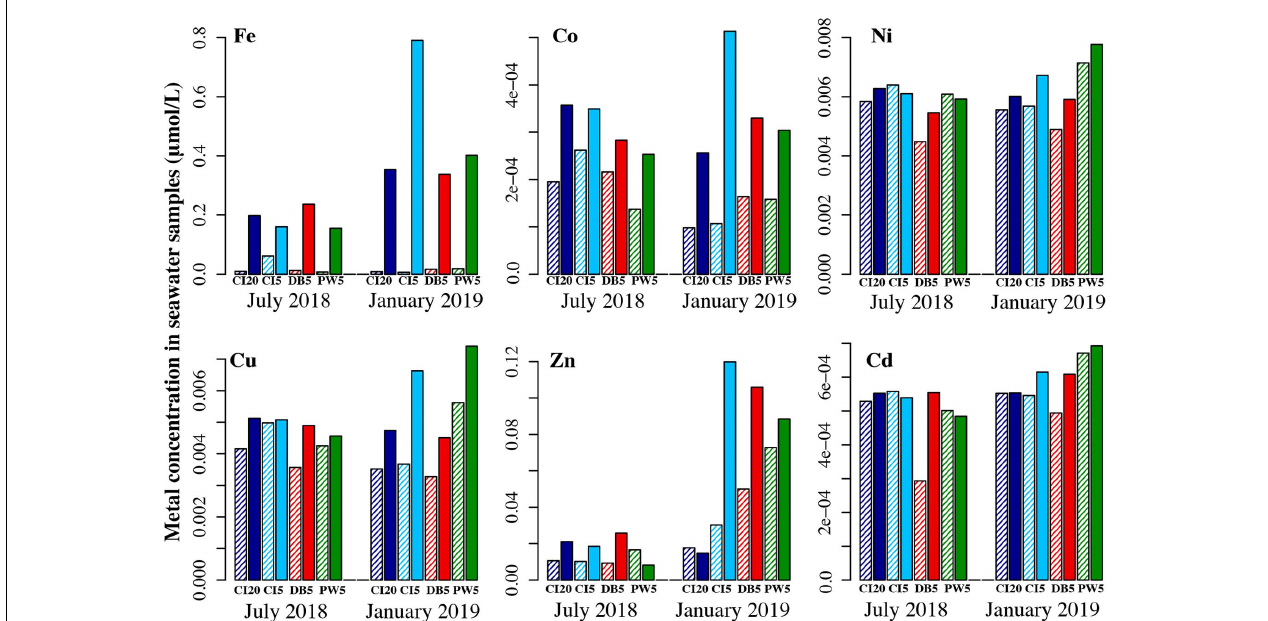
FIGURE 3 | Trace metal analysis of seawater samples collected at the sites when the shellfish cages were deployed (July 2018), and 6 months after deployment began (January 2019). For each pair, the first bar (striped) is the filtered seawater sample, and the second bar (solid) is the unfiltered seawater sample—comparing the two should allow determination of what metals were dissolved in the seawater as opposed to in particulate matter. Dark blue = Carr Inlet 20 m, light blue = Carr Inlet 5 m, green = Point Wells 5 m, and red = Dabob Bay 5 m.